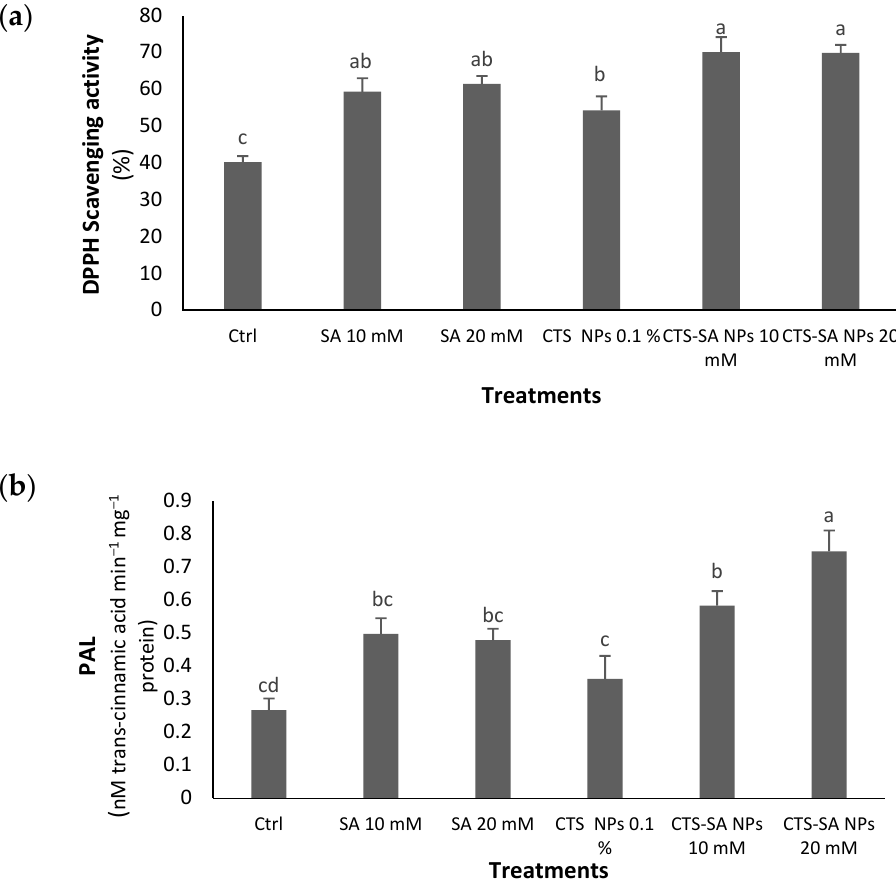
Figure 4. The effect of salicylic acid (SA) (10 and 20 mM), chitosan (CTS) (0.1%), and their combination in nano-form (CTS-SA NPs) treatments on the DPPH scavenging activity (antioxidant activity) ( a ) and PAL enzyme activity ( b ) of the grape ( Vitis vinifera L.) cv. Red Sultana. Different letters indicate significantly different values at p ≤ 0.05.